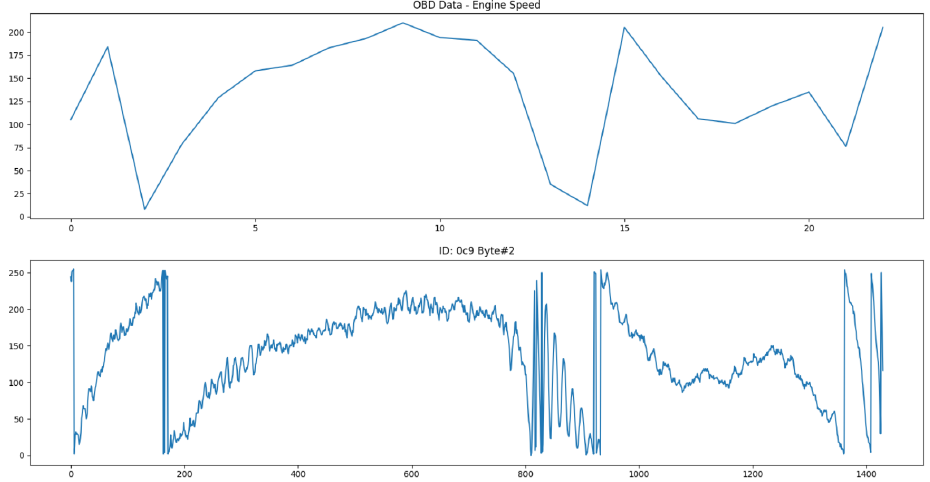
Figure 15. Second byte of OBD-II data for engine speed ( top ) and the best CAN candidate byte ( bottom